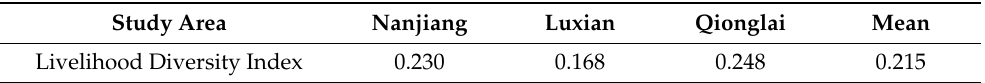
Table 4. Household livelihood diversity index in the different study